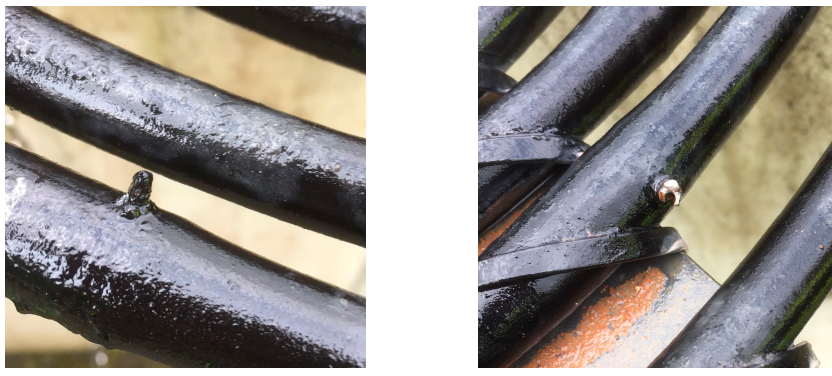
Figure 5. Blocked emitter orifices from an aerated wetland treating landfill leachate.